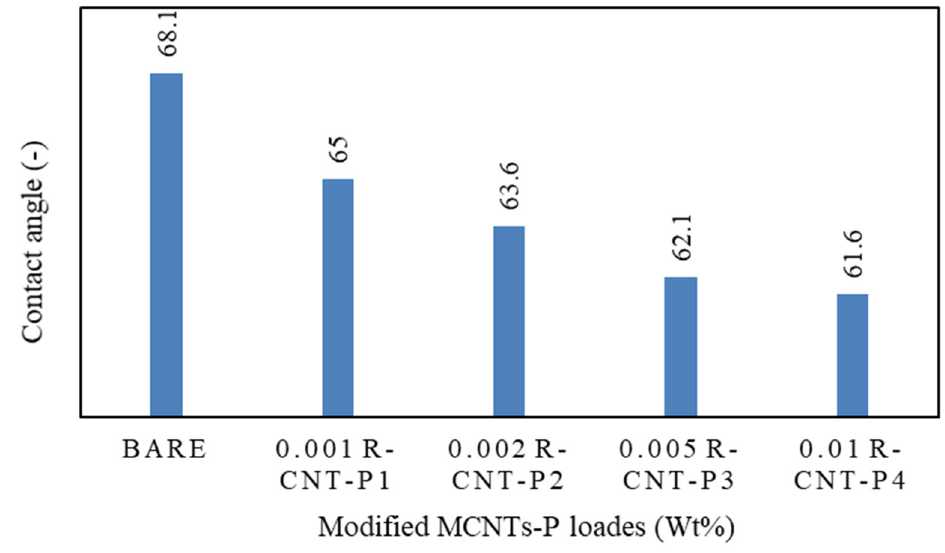
Figure 4. Contact angle analysis of different membranes.